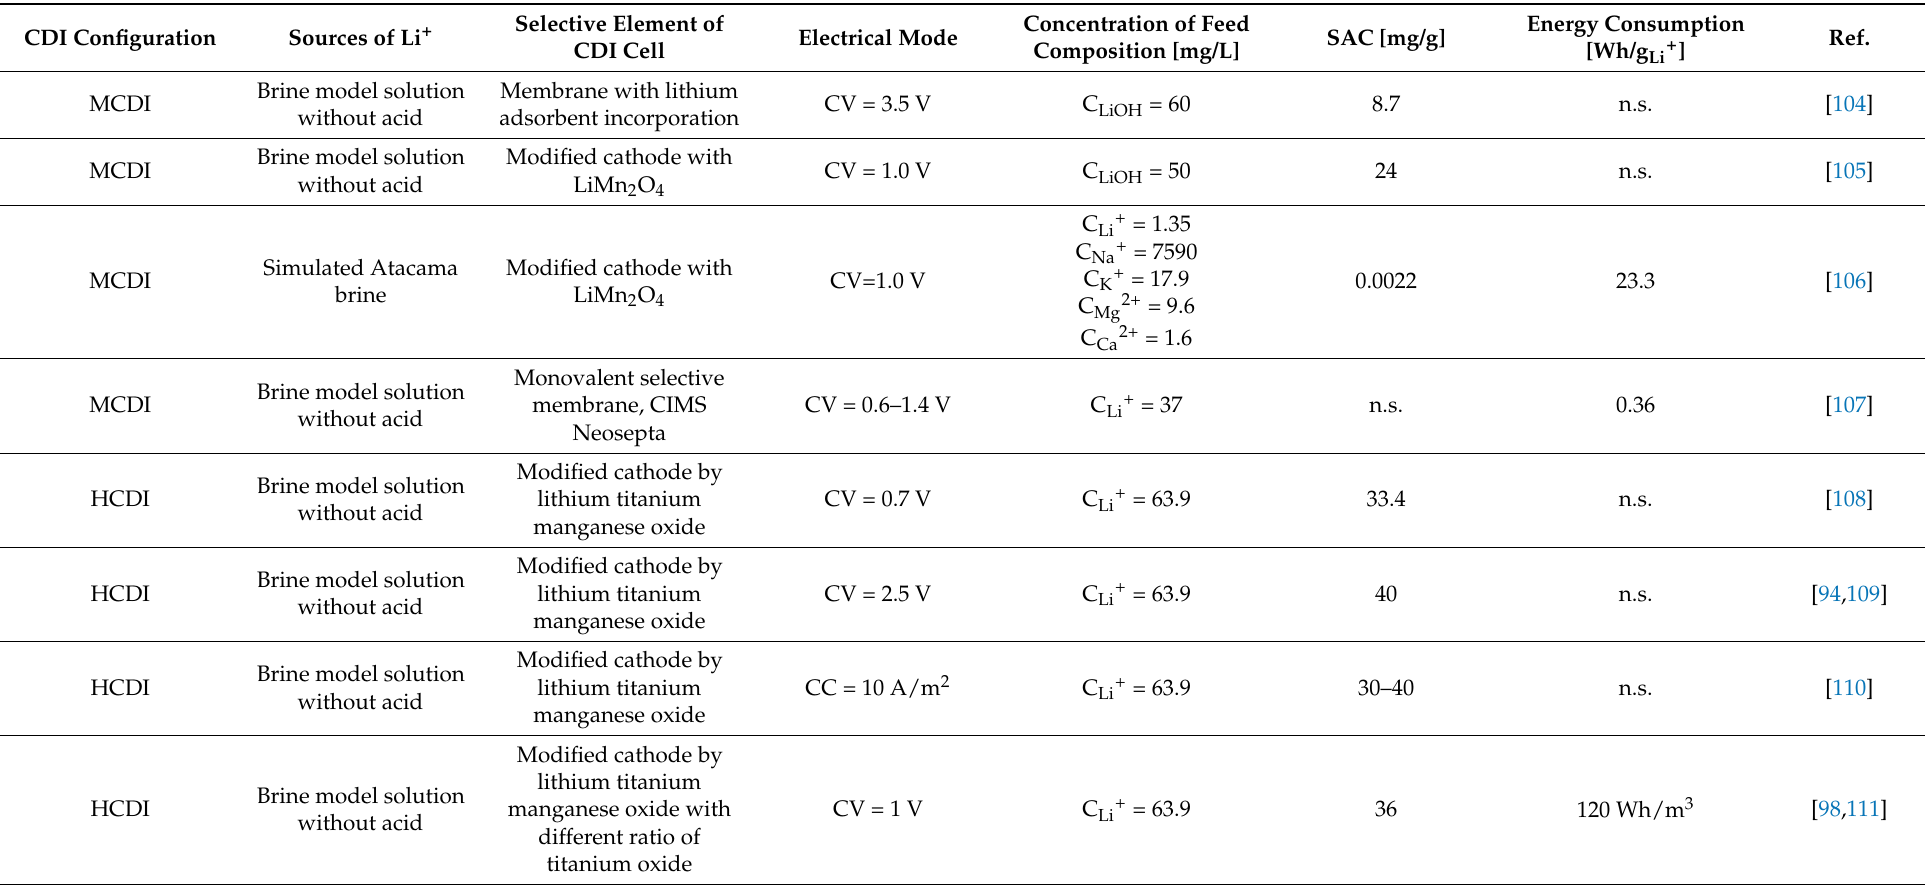
Table 8. Comparison of CDI techniques for lithium removal from